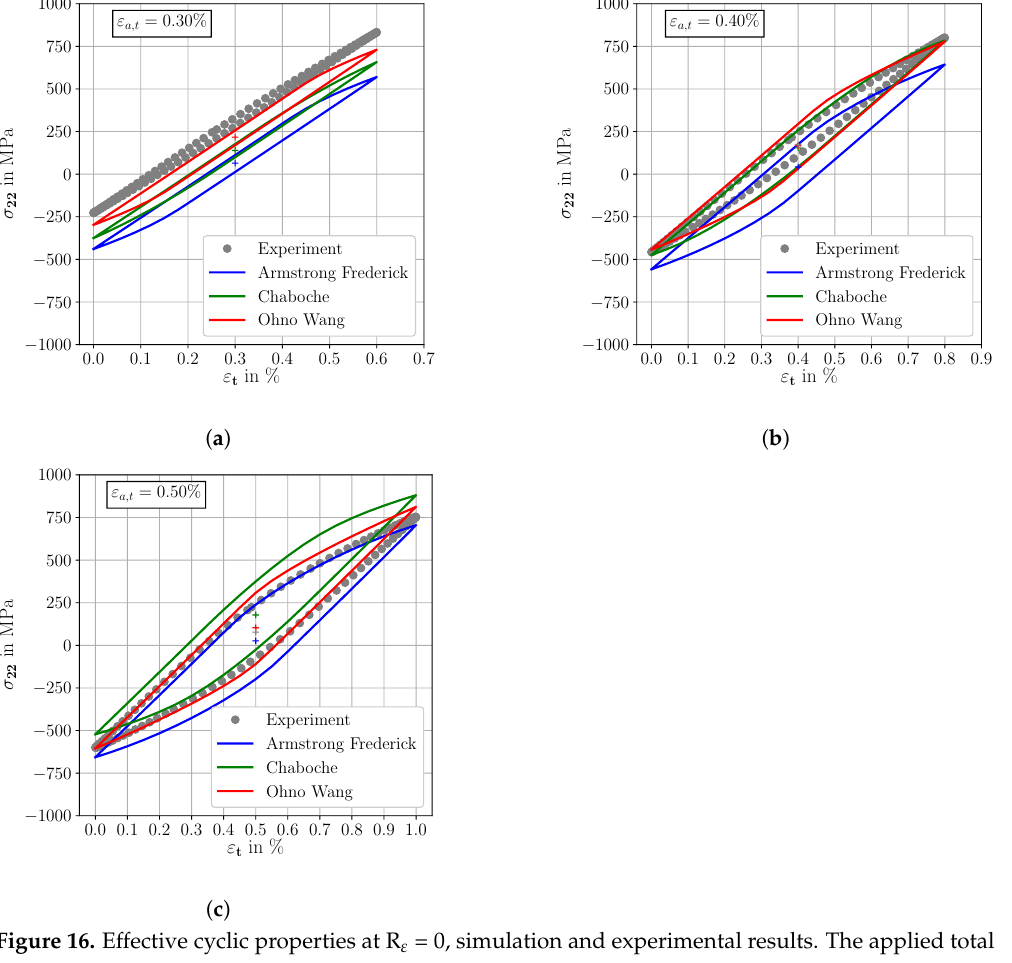
Figure 16. Effective cyclic properties at R ε = 0, simulation and experimental results. The applied total strain amplitudes are ( a ) ε a , t = 0.30%, ( b ) ε a , t = 0.40% and ( c ) ε a , t =